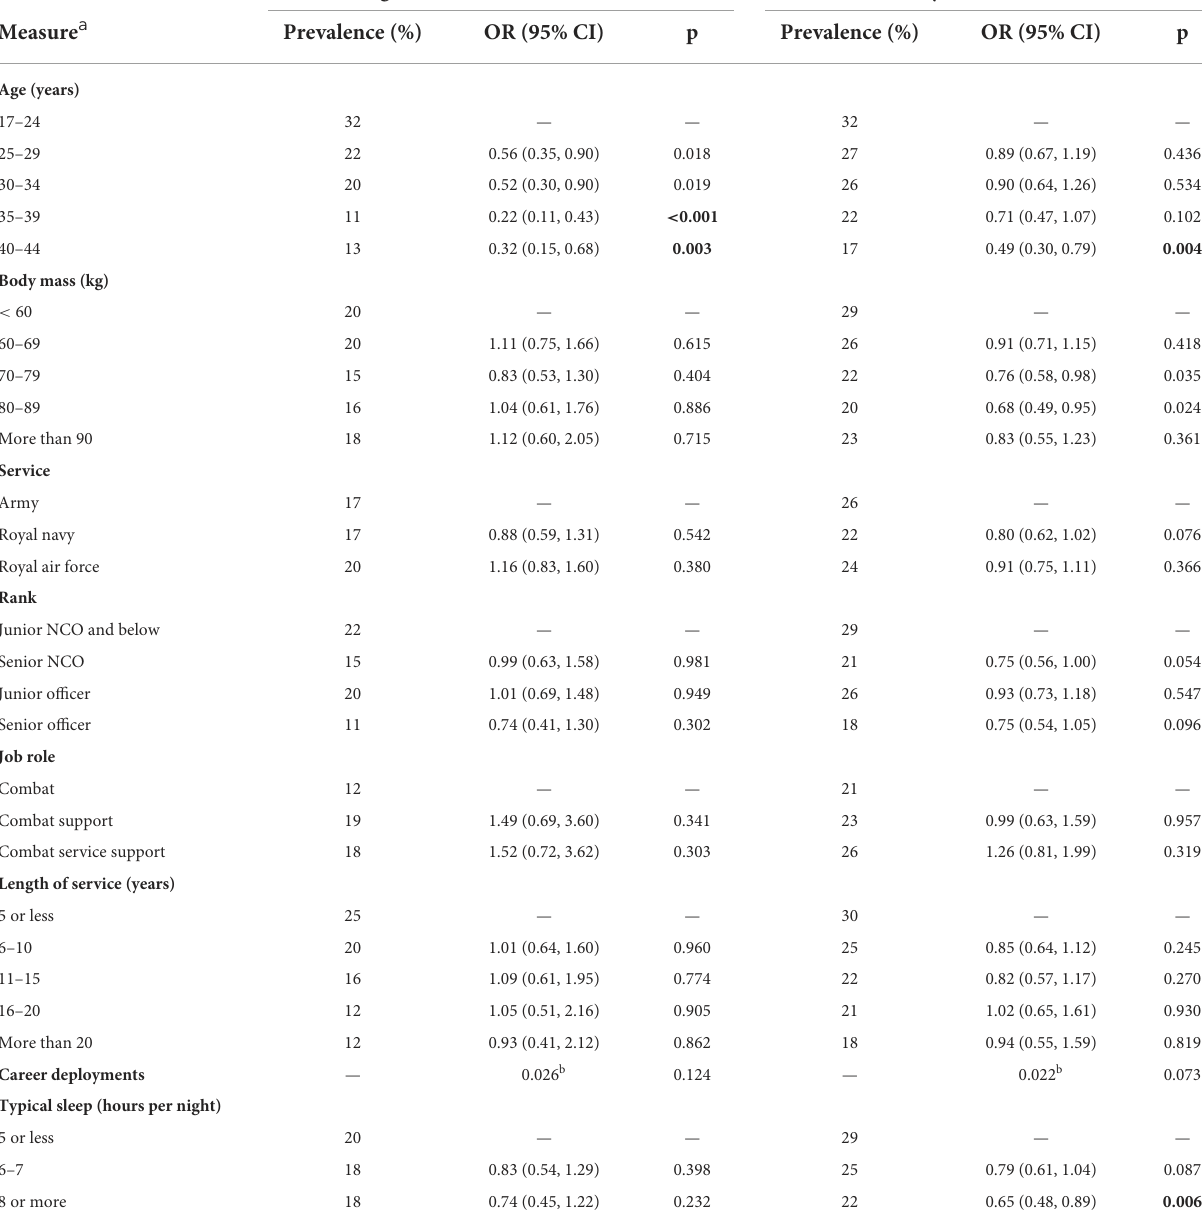
TABLE 4 Associations between demographics and menstrual function.